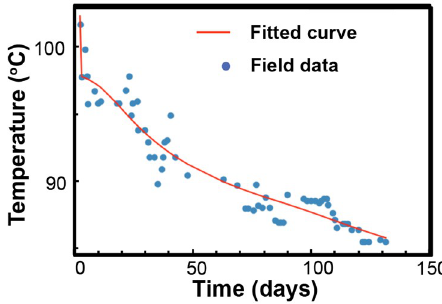
Figure 15. Estimated results of heat transfer area in the Balcova reservoir.